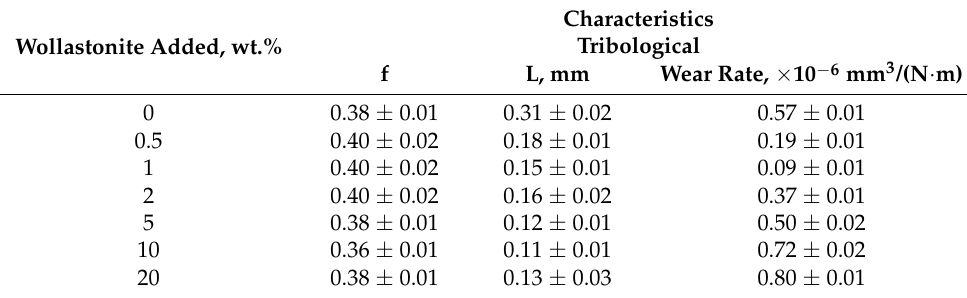
Characteristics Tribological